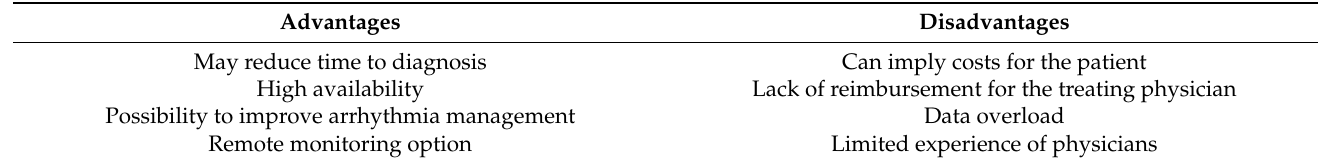
Table 1. Advantages and disadvantages of wearable cardiac rhythm